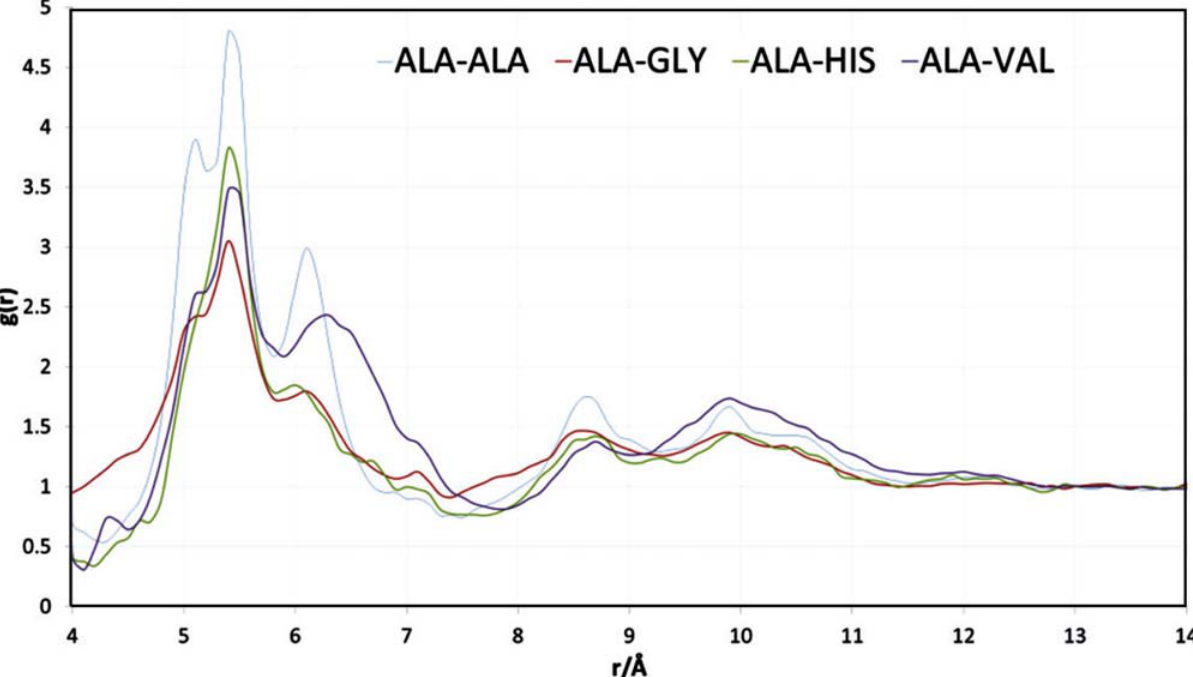
Figure 3. Radial distribution functions for pairs alanine-alanine, alanine-glycine, alanine-histidine and